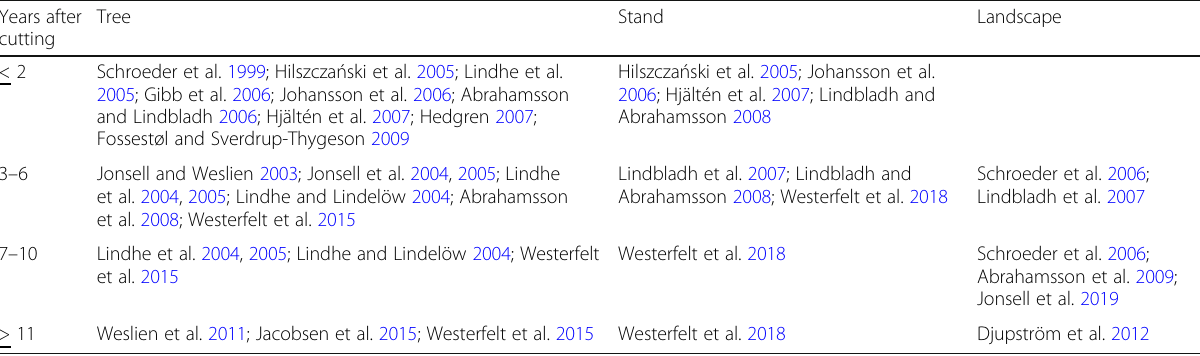
Table 1 Studies on high stumps by age (years after cutting) and spatial scale. The same set of stumps may recur in several papers but with different age, and several spatial scales can be addressed in the same paper Years after Tree cutting